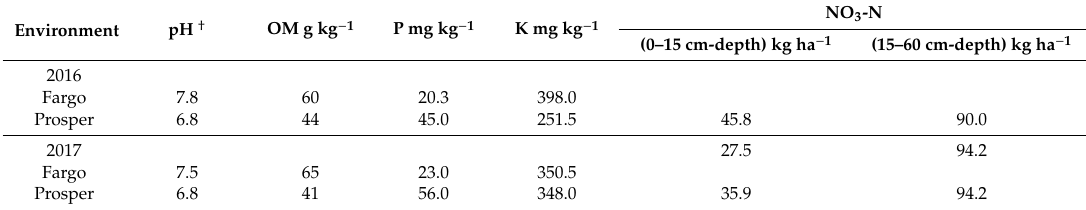
Table 1. Initial soil analysis for experimental sites Fargo and Prosper, ND, 2016 and